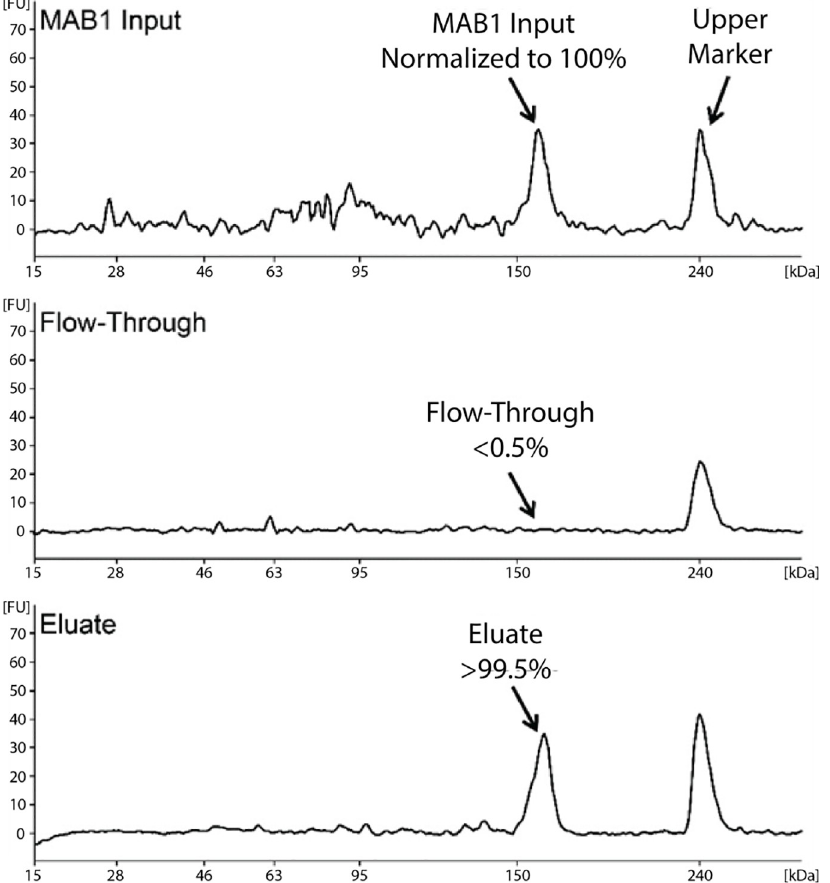
Fig 1. The recovery of the affinity purification of MAB1. The recovery rate of the affinity purification of MAB1 was > 99.5% while < 0.5% total MAB1 was detected in the flow-through. The calculation of percent recovery rate was described in the Materials and Methods section. A known amount of high molecular-weight standard (shown as “Upper Marker”) was run with each sample as an internal normalization control. The ratio of the MAB1 peak area to the Upper Marker peak area in each sample was calculated to correct for run-to-run